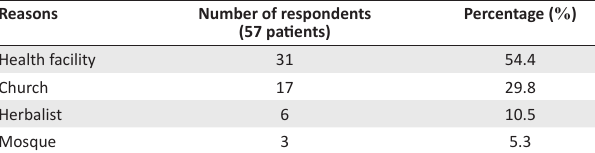
TABLE 2: Respondents’ response to ‘point of first